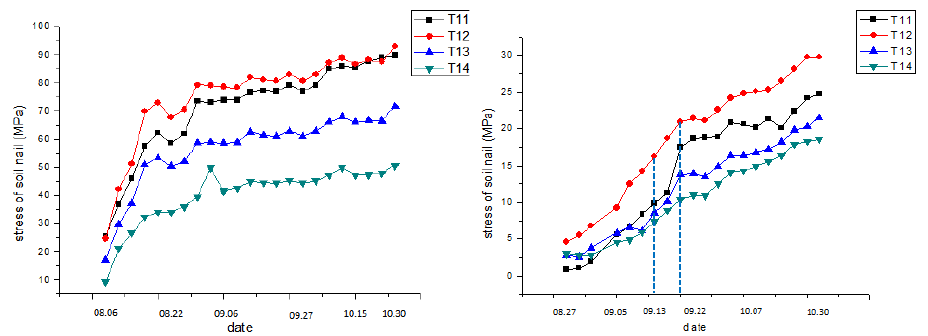
Figure 10. Location of instruments for testing set No. 5.